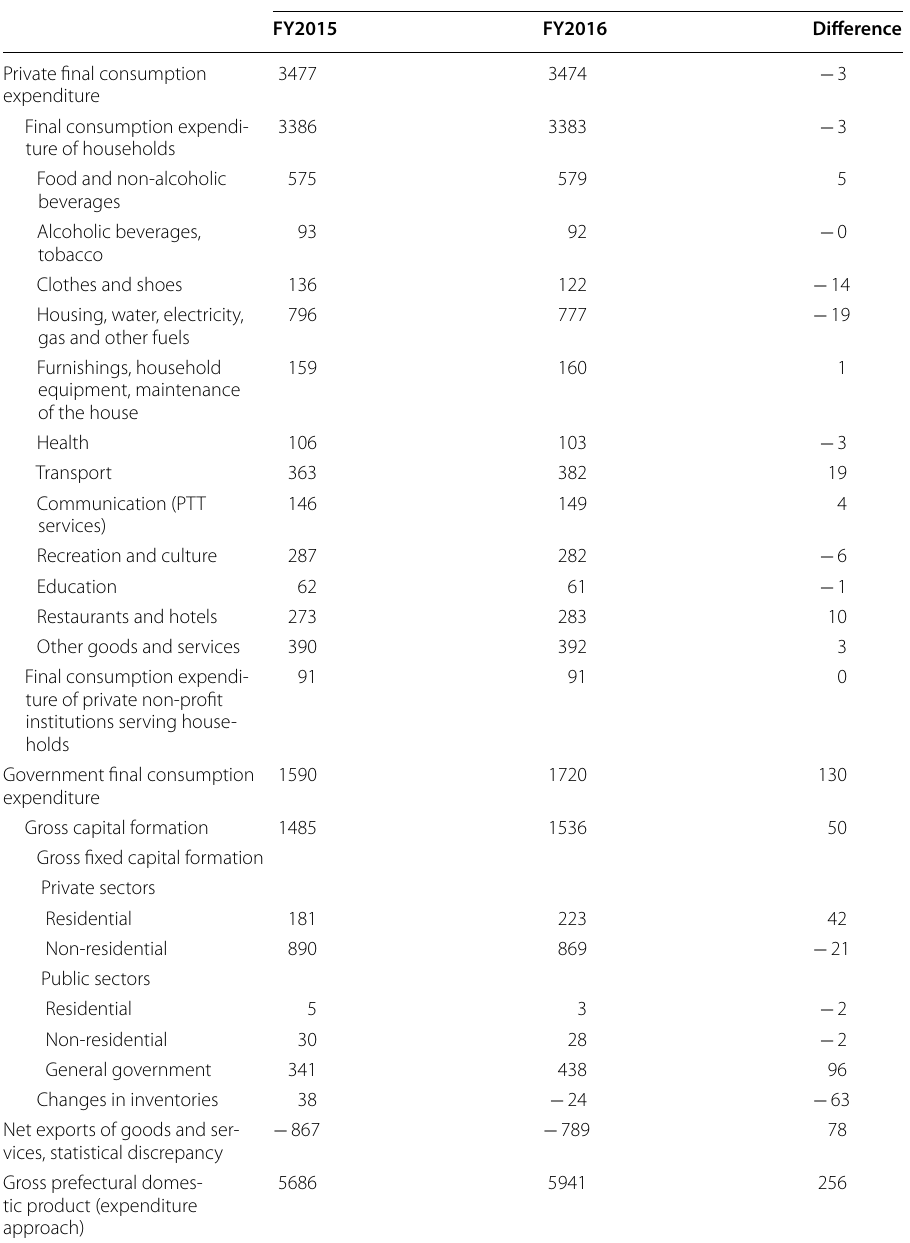
Table 4 Nominal GPDP (expenditure